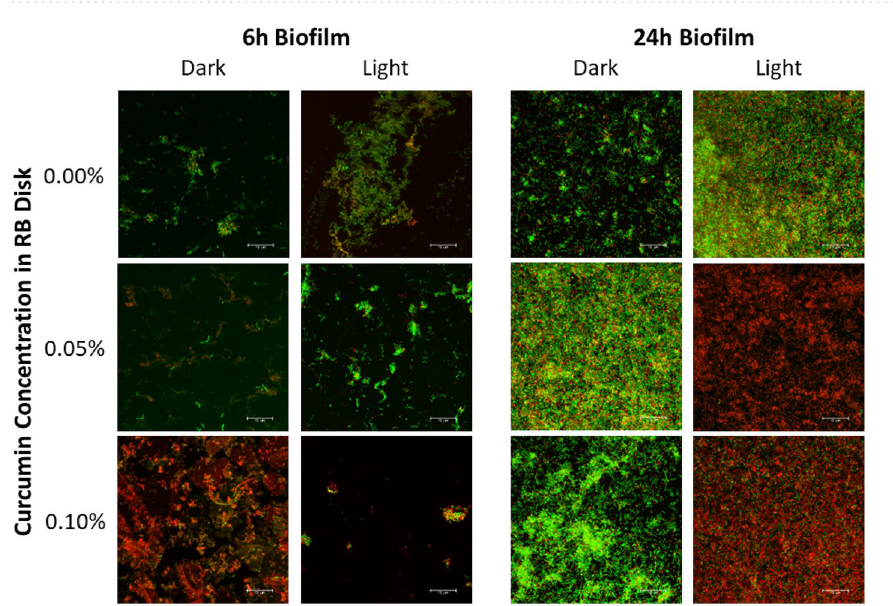
Figure 7. CLSM images of resin disks as a function of curcumin concentration and application of